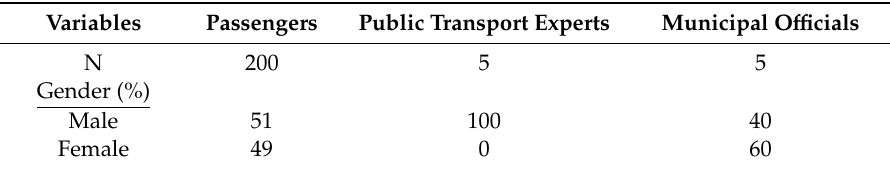
Table 1. Pattern characteristics of participated